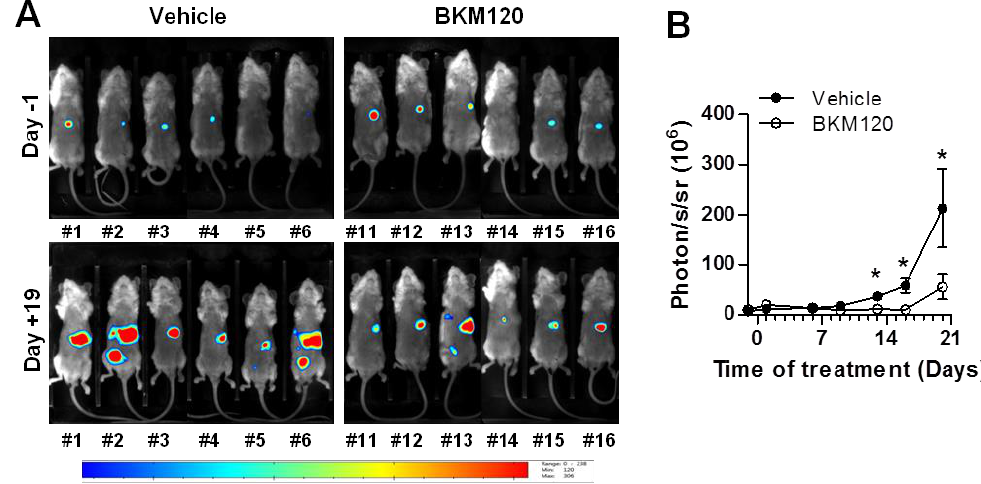
Figure 5. Phosphatidylinositol 3 - kinase (PI3K) inhibitor BKM120 limits MKN45 tumor growth in the stomach and metastases formation in vivo. Luciferase-encoding MKN45 cells were xenografted into the stomach of NSG mice. After seven days, mice were randomized and received, one day after, 20 mg/kg BKM120 or vehicle once per day on a schedule of five days on, two days off for three weeks. Tumor development on whole animals was monitored twice a week by in vivo bioluminescence imaging. Representative images of bioluminescence imaging on live mice ( A ) one day before treatment (upper panels) and after 19 days of treatment (bottom panels) and quantification ( B ). 8 ≤ n ≤ 9 mice. * p < 0.05 vs. vehicle in Student’s t -test. #, mouse identification number.